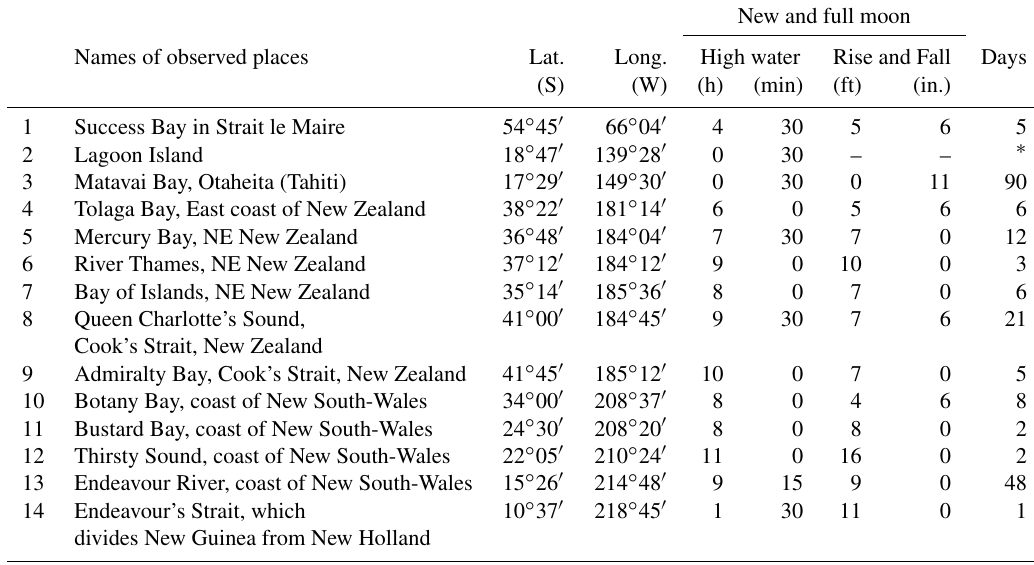
Table 1. The 14 locations where Cook estimated the timing (high water, hours and minutes) and range (rise and fall, feet and inches) of the tide at new and full moon, adapted from the table in Cook (1772). Latitudes and longitudes are as stated by Cook (1772), except for Thirsty Sound (station 12), which is given as 25 ◦ 05 (cid:48) S in Cook (1772). This is an obvious typographical error, with his journal entry of 30 May 1770 being 22 ◦ 05 (cid:48) S. (See the comments on the general quality of Cook’s longitudes in the text.) Rise and fall was not estimated at Lagoon Island (station 2). For Endeavour River (station 13), high water of 9:15 has been assumed, as given in Cook (1776) instead of 9:30 in Cook (1772). The final column shows the approximate number of days that the Endeavour spent at each location as inferred from the daily entries in Cook’s